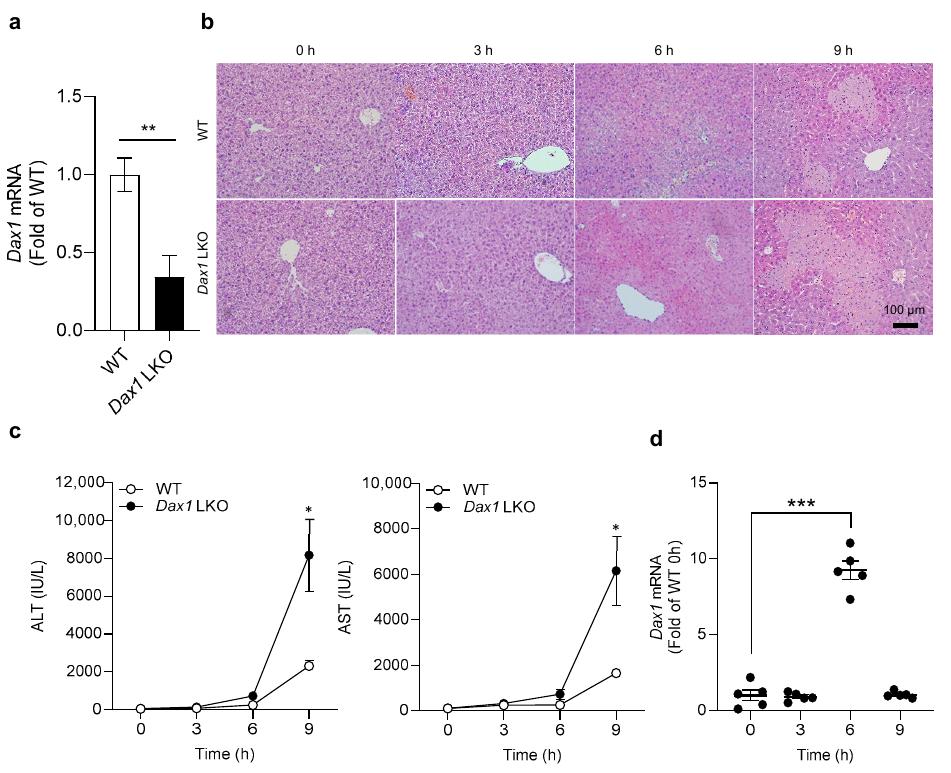
Figure 2. Hepatocyte-specific DAX1 deletion exacerbates the severity of ConA-induced liver injury in mice. ( a ) Primary hepatocytes from WT and Dax1 LKO mice were isolated, and mRNA extracts from cells were conducted using RT-qPCR to measure the expression levels of Dax1 (RT-qPCR was performed in five technical replicates). ( b – d ) WT and hepatocyte-specific Dax1 knockout (LKO) mice were treated with a single administration of ConA (15 mg/kg, i.v.) for 0, 3, 6, and 9 h (WT; n = 5–6, LKO; n = 6–7). ( b ) H&E staining was performed in the liver tissues at various time points, and representative images are shown. ( c ) The plasma levels of ALT and AST were measured at the 4-time points. ( d ) The liver samples from WT mice were harvested and subjected to RTqPCR for measuring the expression levels of Dax1 at 4-time course after ConA injection (five technical replicates for each pooled sample from WT mice). Data are expressed as the mean ± SEM. Two-tailed Student’s t -test was used to compare the LKO and WT groups ( a ) and the LKO groups at each time point with respective WT groups ( c ); Tukey–Kramer test after the one-way ANOVA was used to compare each time point with zero time ( d ); * p < 0.05, ** p < 0.01, and *** p < 0.001.